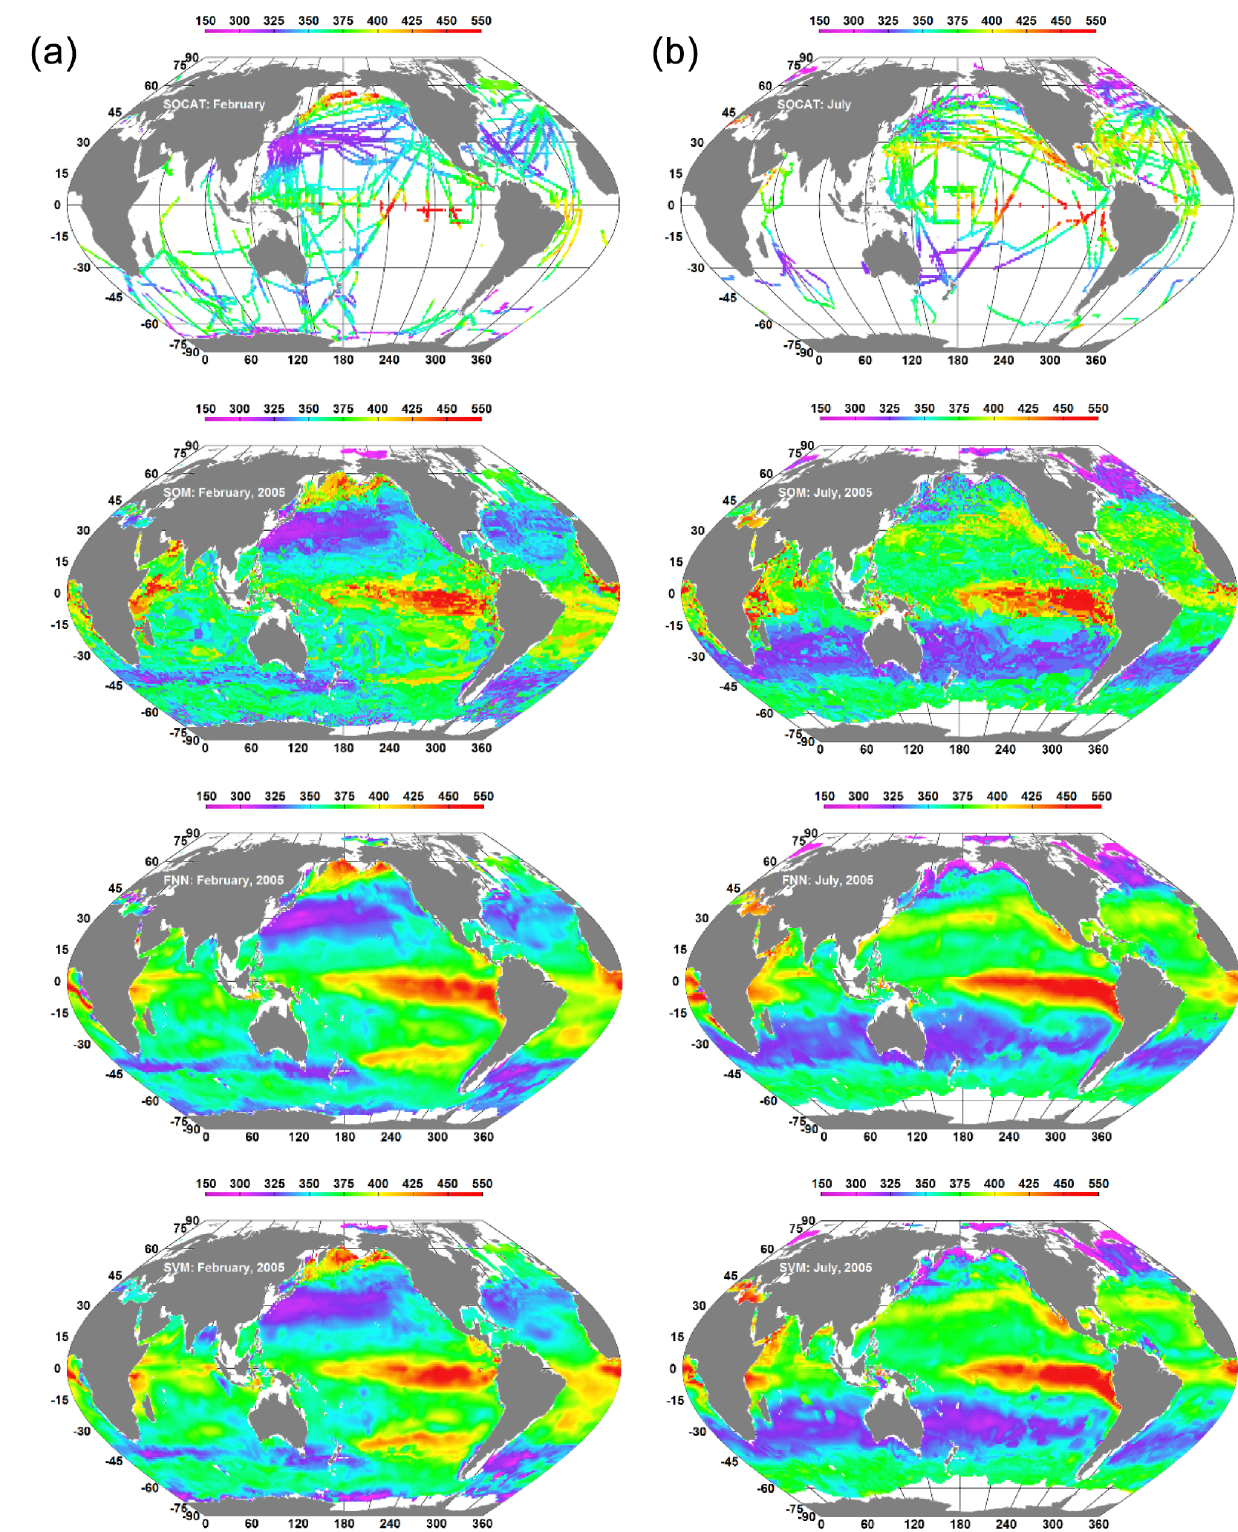
Figure 3. Distributions of modeled and observed f CO 2 . The composite map for observations includes f CO 2 in 1990–2014. Half of ran- domly selected data points were used to train FNN and SVM and to label SOM to make predictions. (a) shows February and (b) shows